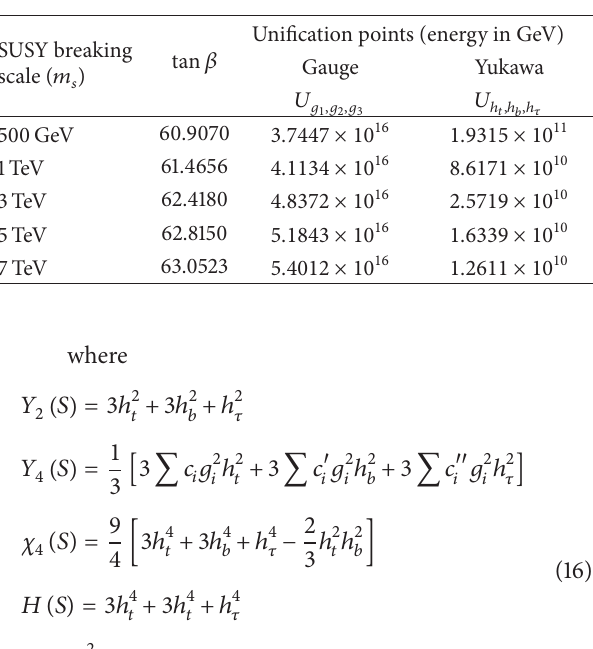
Table 6: Approximate gauge unification points and Yukawa unifi- cation points for central value of 𝑔 DR 3 = 1 .